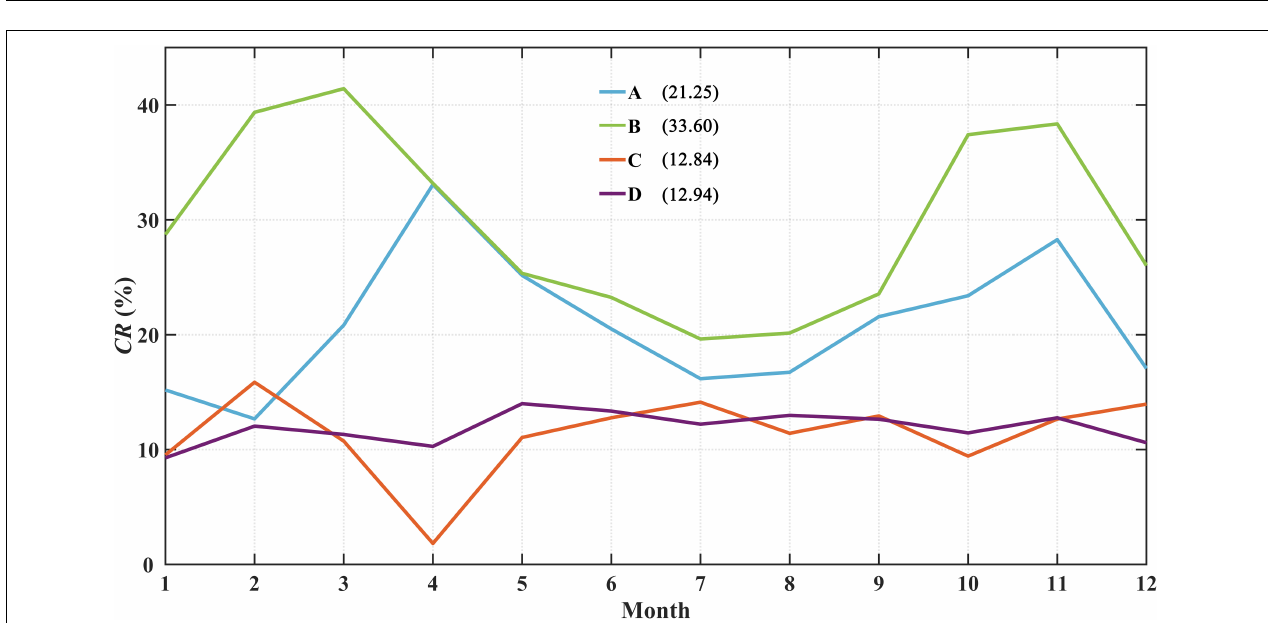
FIGURE 6 | The spatial distribution of (A) yearly average CR representing the contribution of fortnight Chl- a bloom induced by spring-neap tide on Chl- a level and (B) the proportion of intraseasonal variation in Chl- a explained by the spring-neap tidal cycles.